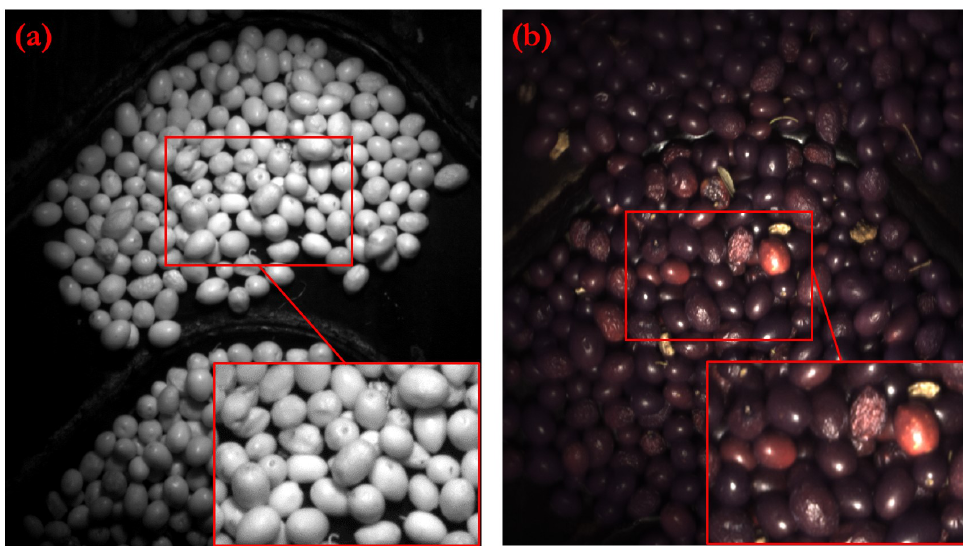
Figure 2. Images acquired on the conveyor after the cleaning process. ( a ) Infrared camera (Nano M2590-NIR). ( b ) Visible band camera (Nano C242).